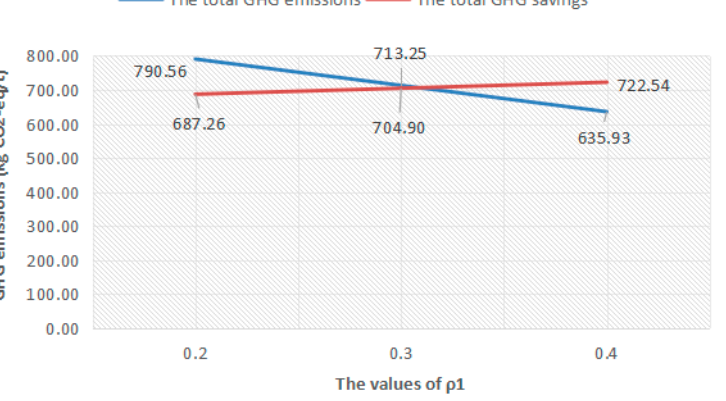
Figure 4. The influence of the ratio of processing strategies on total GHG emissions and total GHG savings.